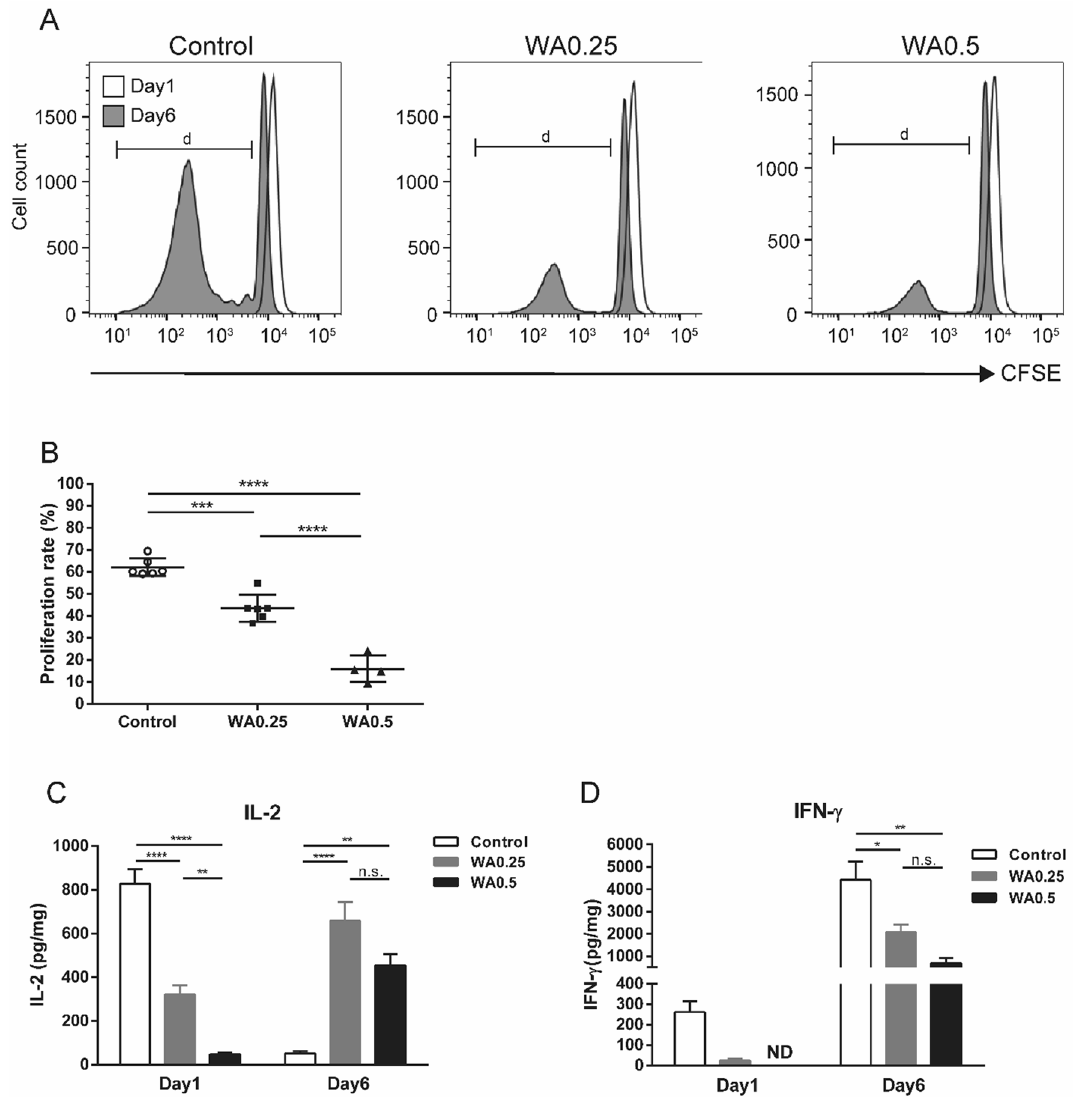
Figure 4. Suppression effect of WA on mixed human lymphocyte reactions. CFSE-labeled human PBMCs were used as responder cells. Mitomycin C-pretreated allogeneic human spleen cells were used as stimulator cells and were cocultured with or without WA 0.25 μg/mL (WA0.25) or WA 0.5 μg/mL (WA0.5) treatment. ( A ) Representative time-dependent change of CD4 + T-cell proliferation was detected by flow cytometry analysis of CFSE-stained cells. The clear histogram represents CD4 + T-cell proliferation at 1 day, while the gray area represents the cell proliferation at 6 days. ( B ) The proliferation rate (%) was calculated as a proportion of daughter cells at 6-day culture. ( C , D ) The levels of IL-2 or IFN-γ produced in the supernatants at day 1 and day 6 MLR were quantitated by enzyme-linked immunosorbent assay. Control (n = 6), WA0.25 (n = 6), WA0.5 (n = 4). * P < 0.05, ** P < 0.01, *** P < 0.001, **** P < 0.0001. ND not